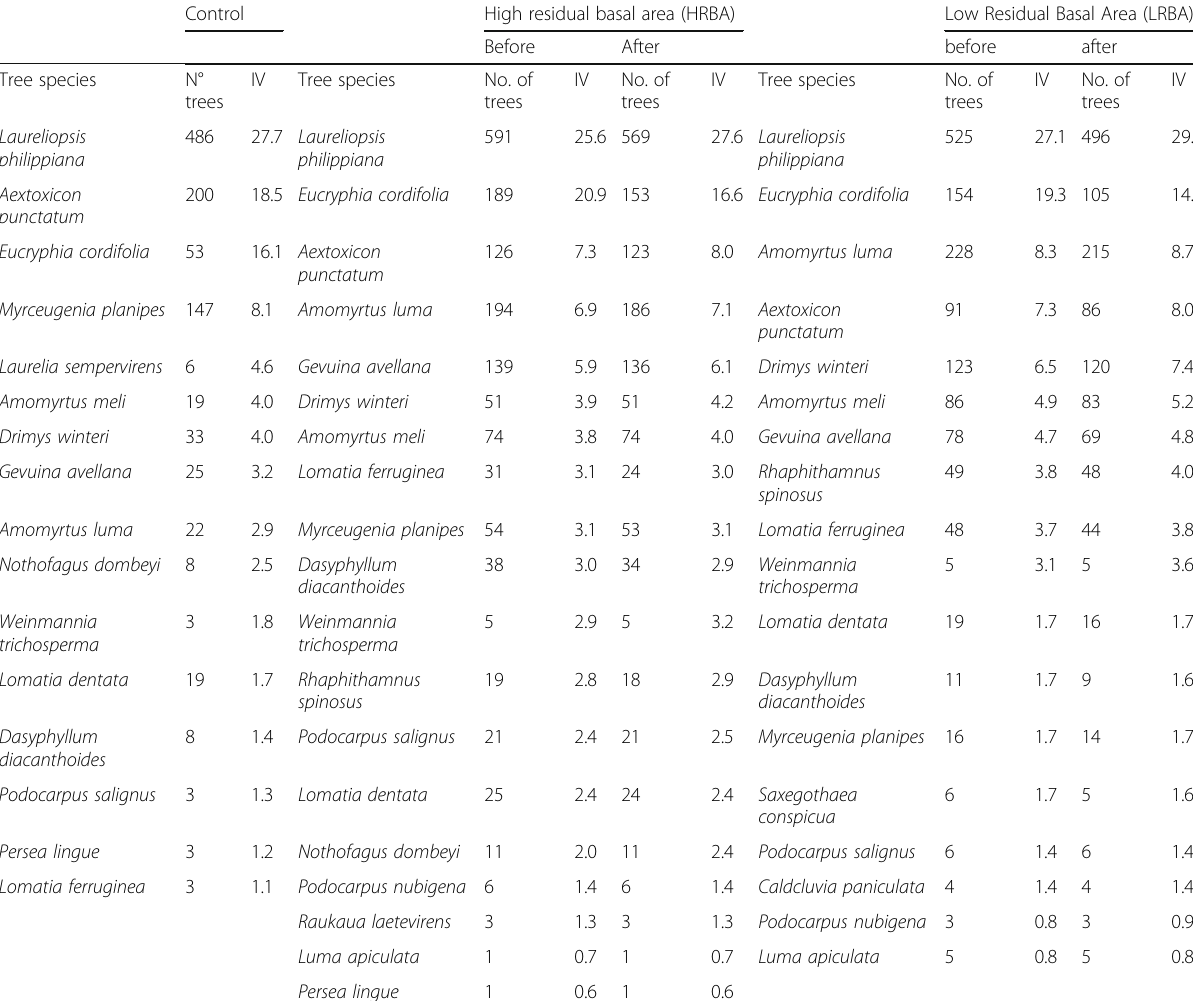
Table 5 Average number of trees per hectare and importance value (IV) in % per treatment and species in 2012 and 2014